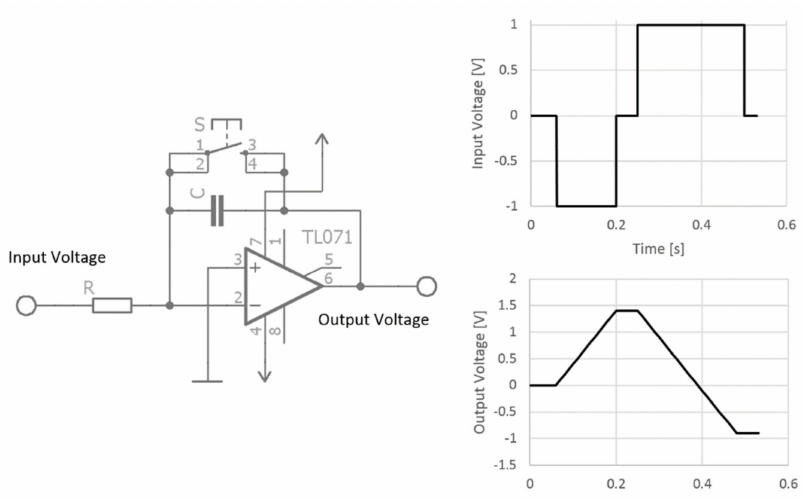
Figure 5. Integration method circuit diagram and working principle.